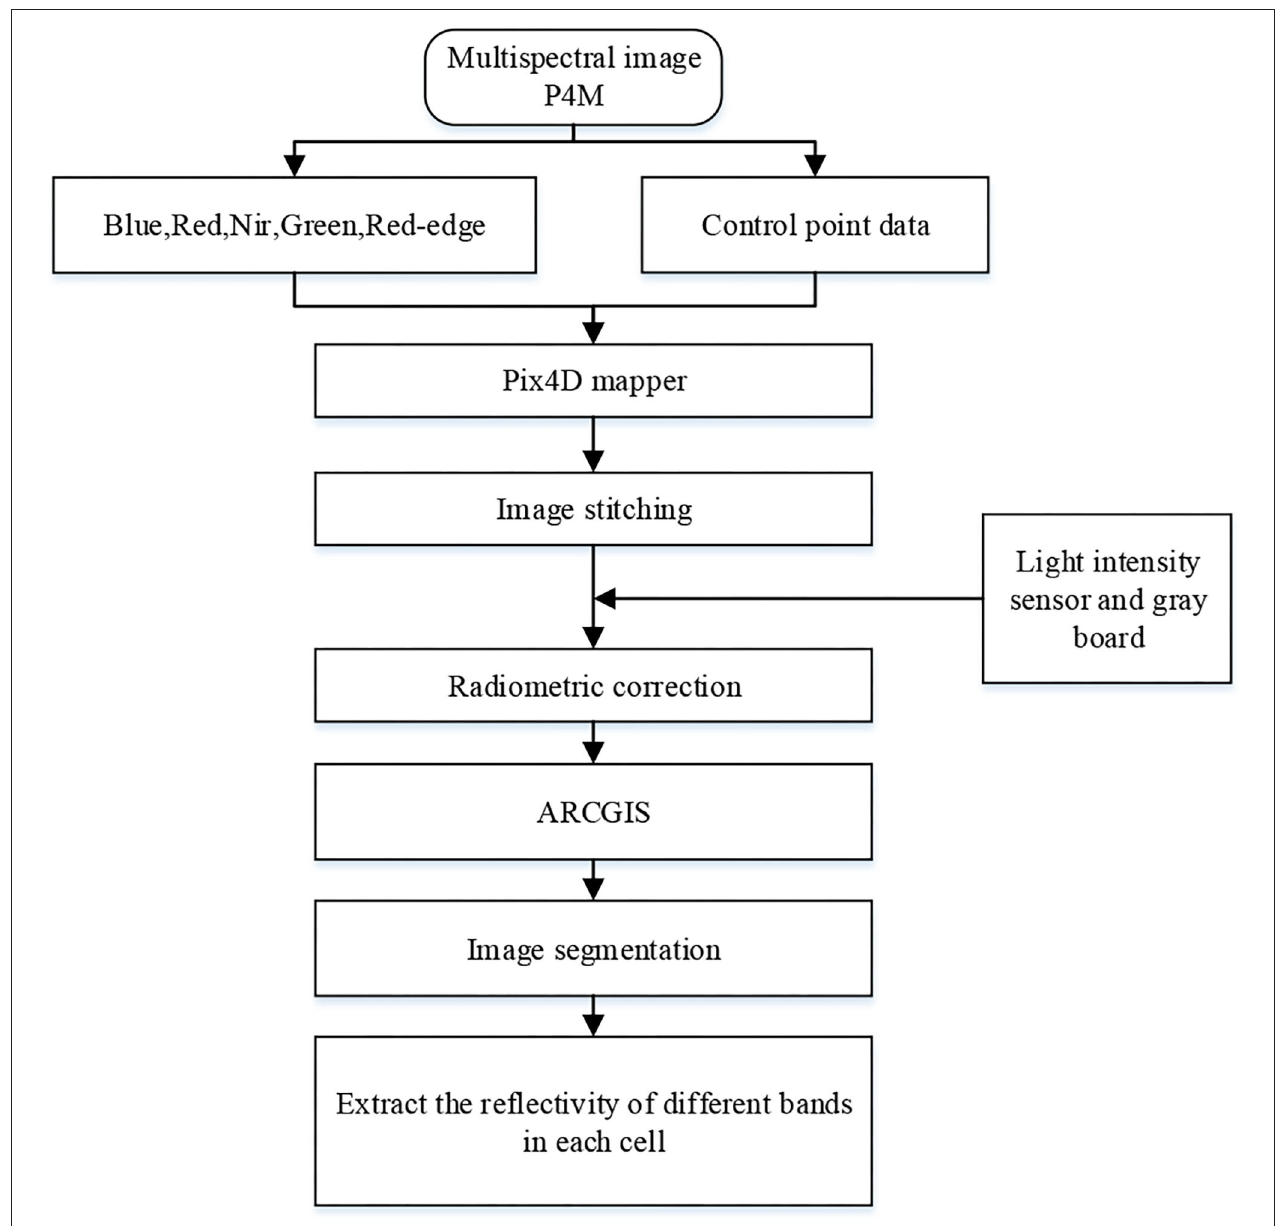
FIGURE 1 | Flowchart of unmanned aerial vehicle (UAV) image